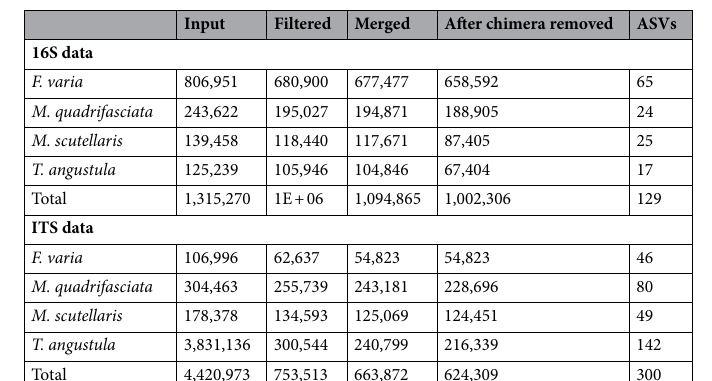
Table 1. Reads processed by Dada2—R package.